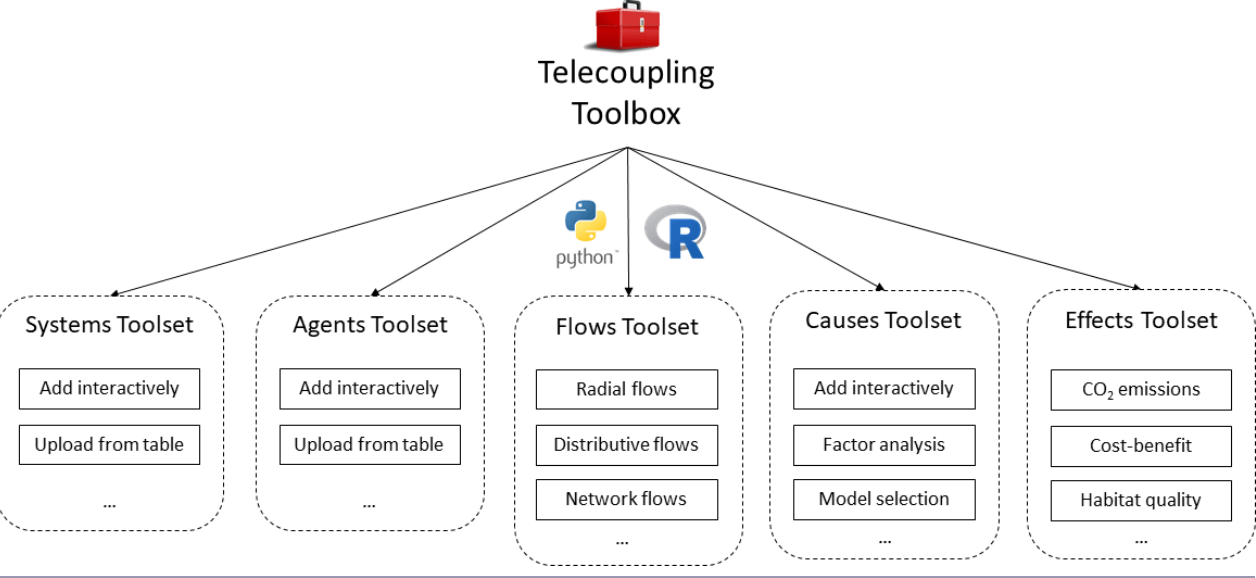
Fig. 1 . Structure of the Telecoupling Toolbox and its components. The toolbox includes five toolsets related to each component of the telecoupling framework (systems, agents, flows, causes, effects). Each toolset is made of several custom Python and R